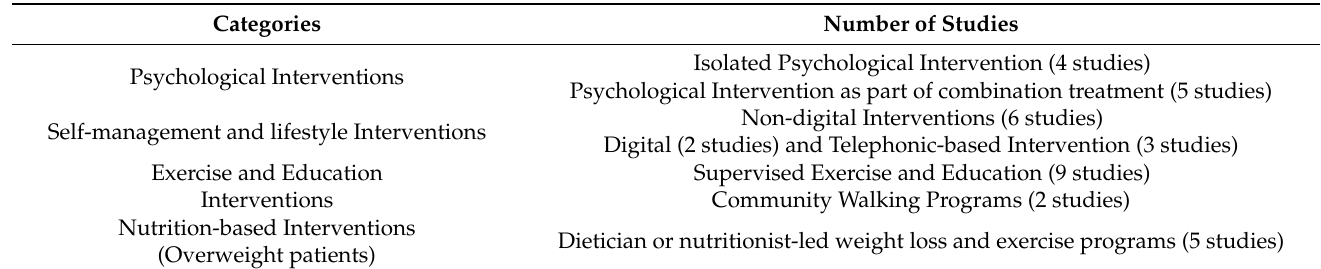
Table 2. Summary of Results.